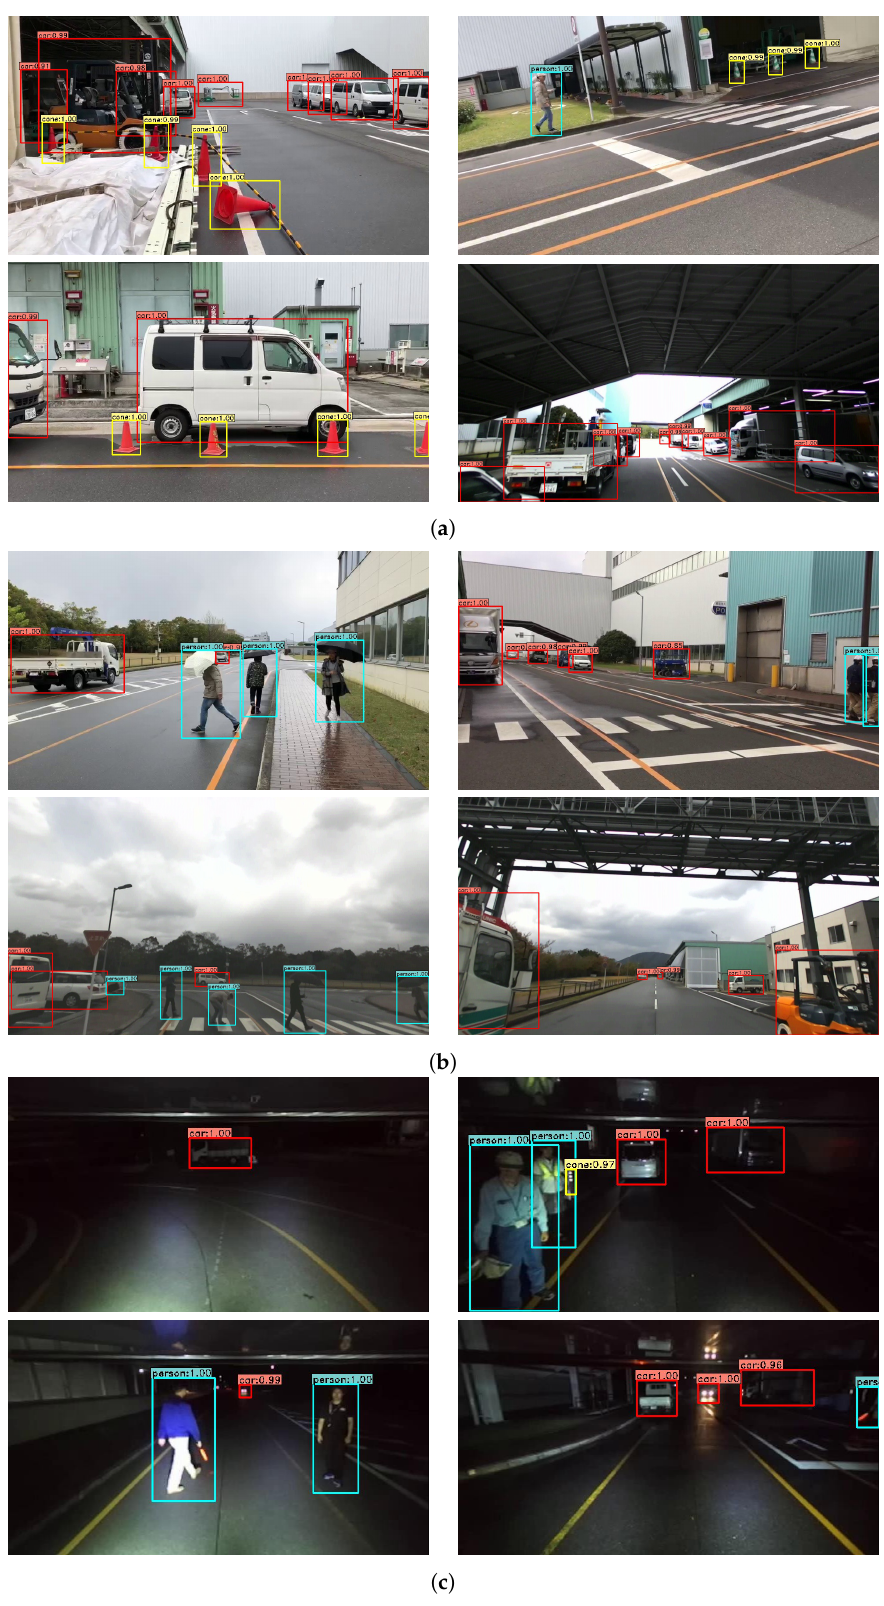
Figure 6. Real-time detection results in different lighting conditions and weathers in factory scenarios. ( a ) Detection results on sunny days; ( b ) Detection results on rainy days; ( c ) Detection results in the